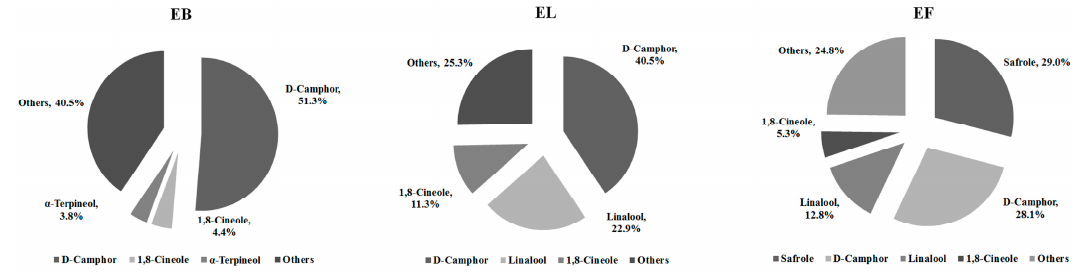
Figure A1. The major components of essential oils.